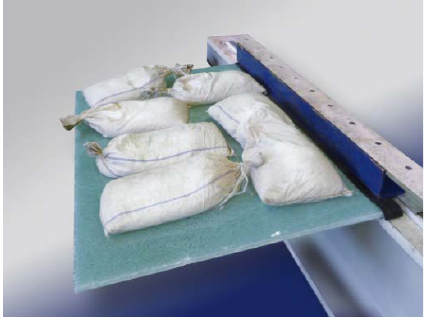
Fig. 3 Demonstration of the residual load-bearing capacity of laminated safety glass with structural PVB interlayer after breakage of both panes and planar load (Singh and Stelzer